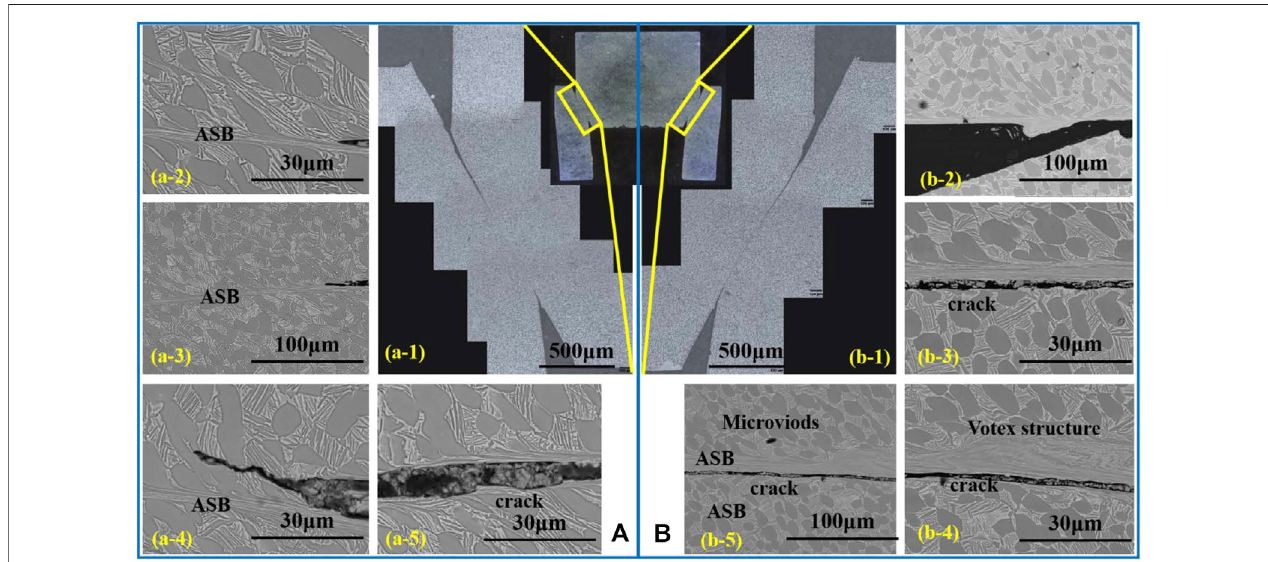
FIGURE6| Themulti-scalesSEMcharacterizationsofadiabaticshearbandsinthehat-shapedspecimenatstrainrateof2.3×10 4 s − 1 , (A) theleftpart; (B) theright part. The additional numbers identify the typical features of selected